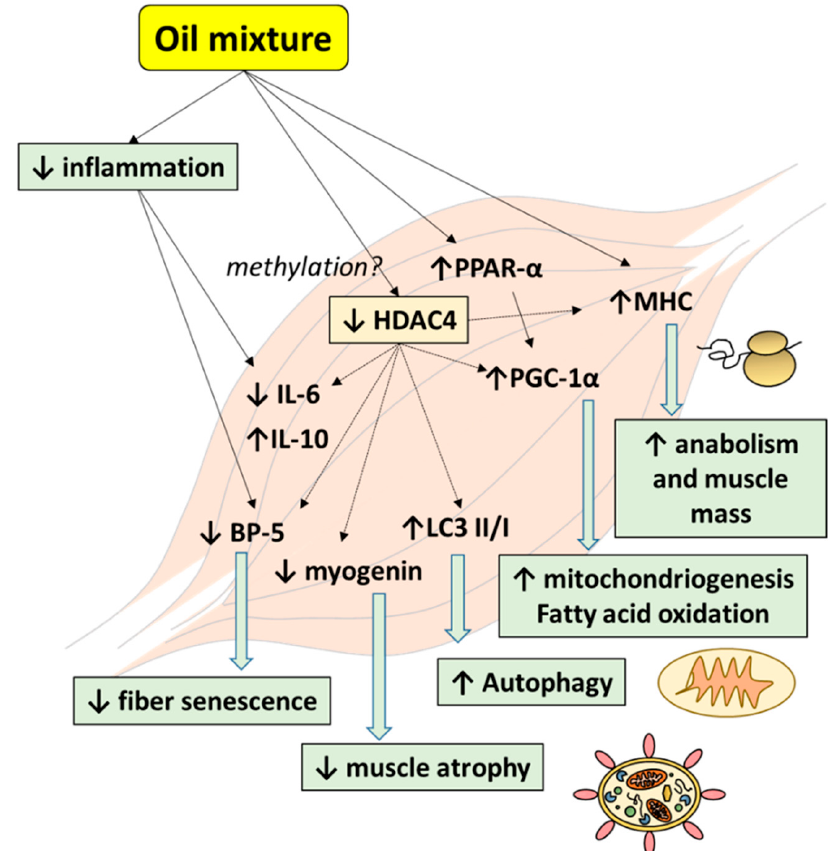
Figure 6. Schematic representation of the effects of the oil mixture on the main aged-induced alterations in skeletal muscle. Oil mixture administration prevented the age-induced increase of HDAC-4. This effect, together with the decrease in inflammatory mediators, may have beneficial consequences such as the prevention of the fiber senescence and muscle atrophy, restoration of autophagy equilibrium, increase in mitochondriogenesis, fatty acid oxidation rate, and protein synthesis. All these effects help to prevent the development of sarcopenia (see Discussion for further details). Abbreviations: BP-5 (insulin-like growth factor I binding protein 5); HDAC-4 (histone deacetylase 4); IL (interleukin); LC3 (1A/1B-light chain 3); MHC (myosin heavy chain); PGC- 1 α (peroxisome proliferator-activated receptor gamma coactivator 1-alpha); PPAR- α (proliferator- activated receptor alpha).